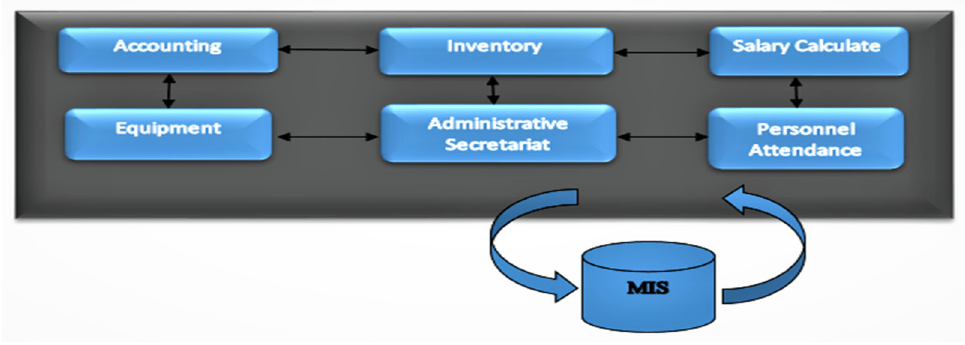
Figure 2. Prevalent subsystems of MIS.